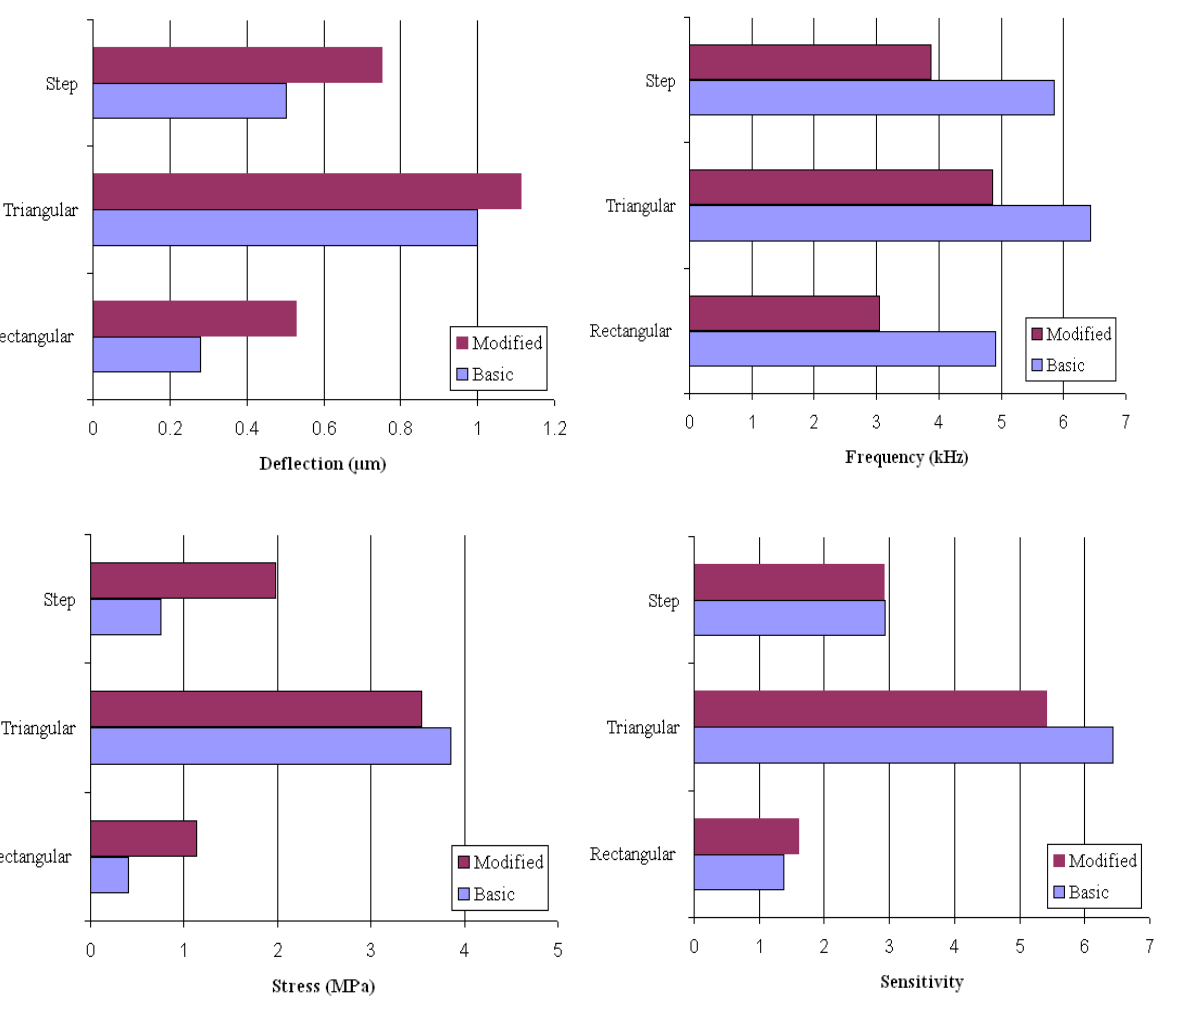
Table 2. Comparison between normalized values for maximum deflection, fundamental resonant frequency, sensitivity and maximum induced